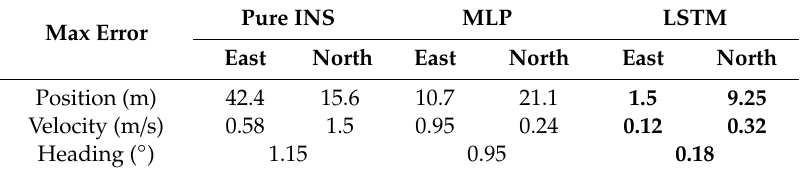
Figure 14. Heading errors of 60 s outages with different algorithms.